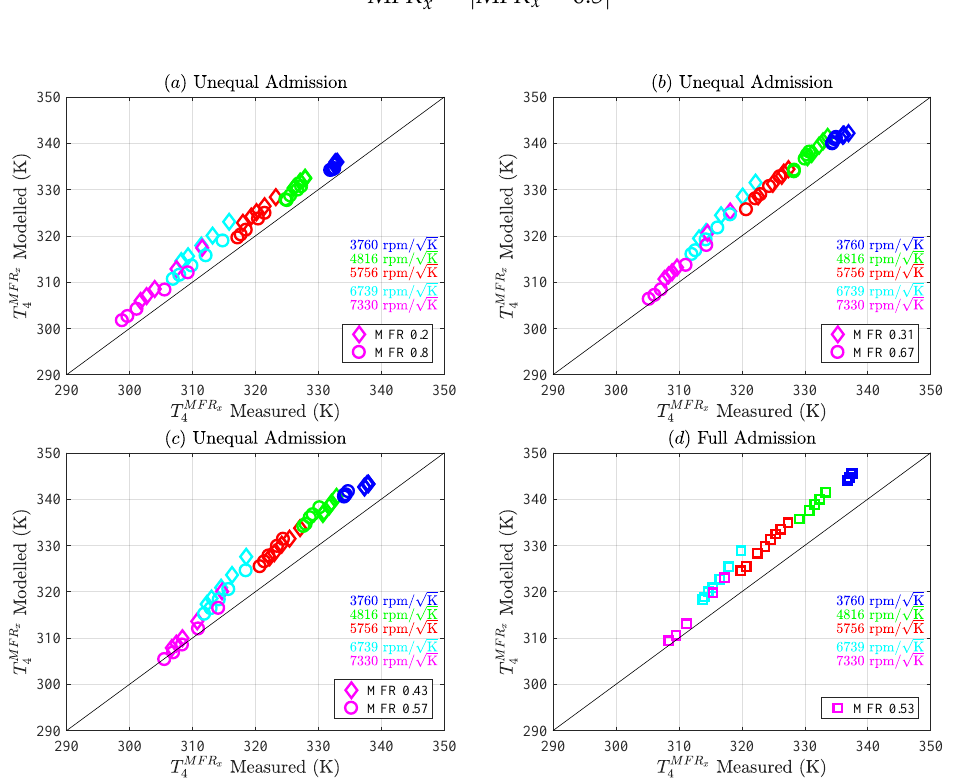
Figure 20. Estimated mixed turbine outlet temperature for full and unequal flows using extrapolated maps of MFR 0 and 1 for T#1TE.